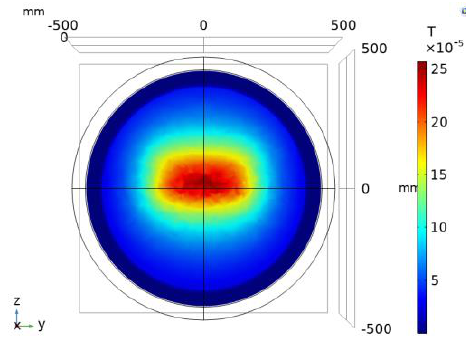
Figure 18. Square coil with plane cores on the primary side and secondary side.